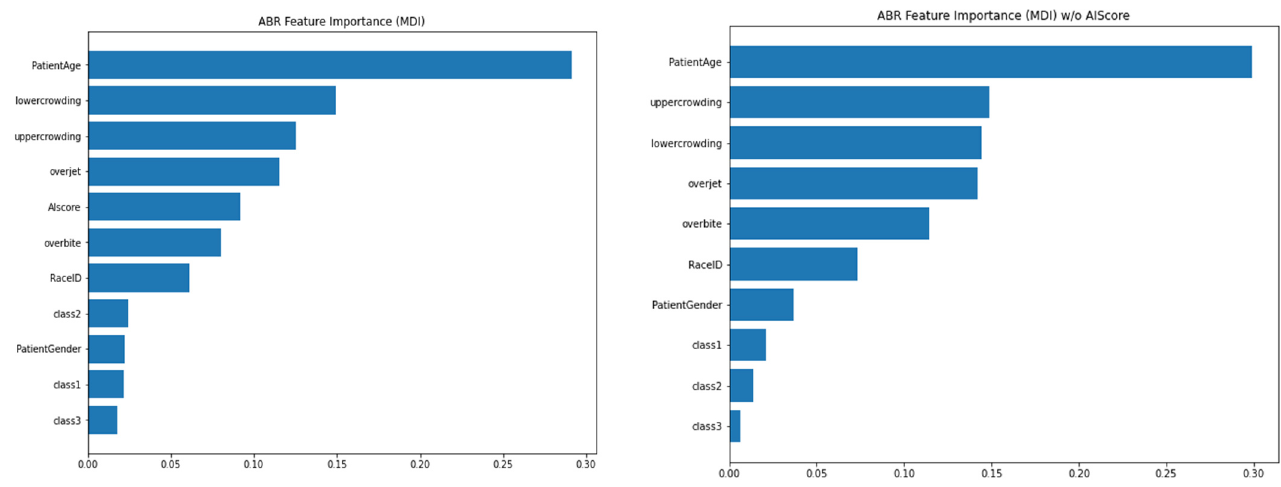
Figure 8. Feature importance in the adaboost model.